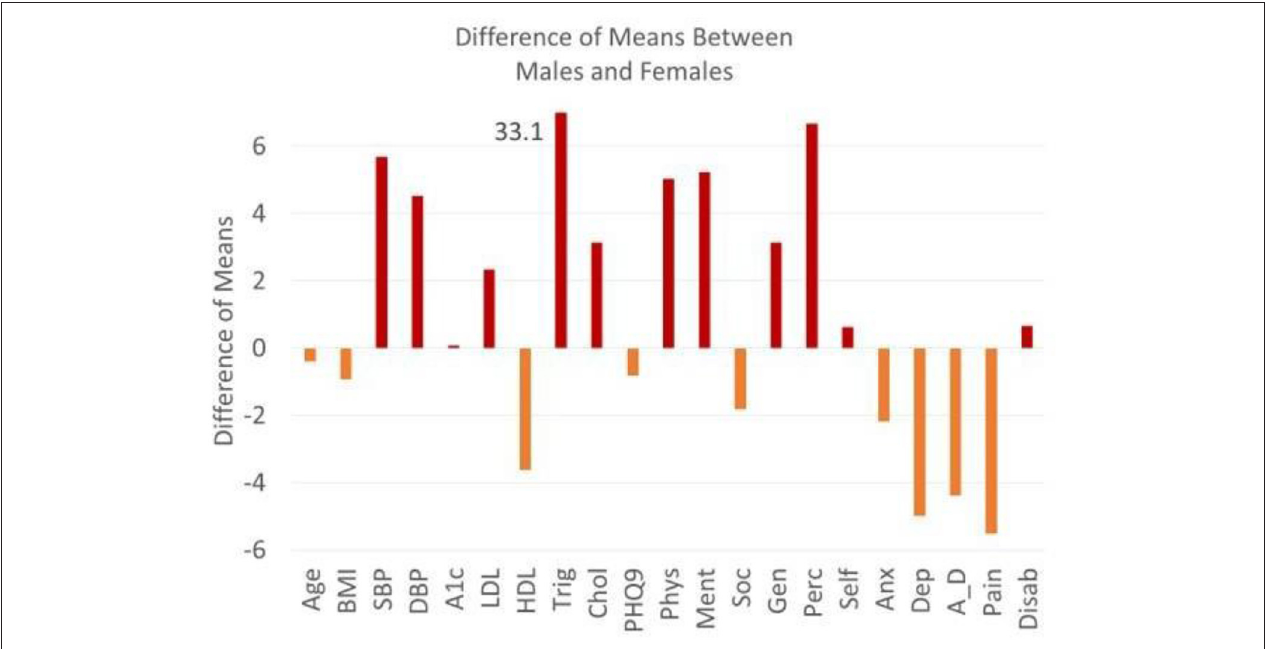
FIGURE 2 | Differences of means between males and females. The plot of the difference of means as calculated by hoteling T2 is the squared difference of mean vectors scaled against the co-variance matrix for age (yrs), BMI, SBP (systolic blood pressure), DBP diastolic blood pressure, A1c (HbA1C), LDL, HDL, Trig (Triglycerides), Chol (Cholesterol), PHQ9, physical health, mental health, social health, general health, perceived health, self-esteem, anxiety, depression, anxiety-depression, pain, disability. Above zero reflects a higher male value (red) and below zero reflects a higher female value (orange). Triglyceride means do not fit on the graph and are defined by the means across gender.